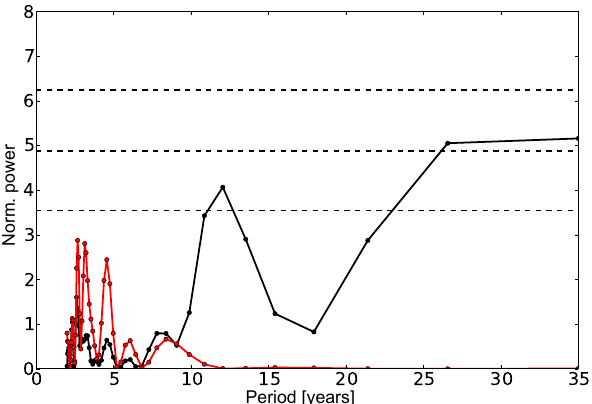
Figure 13. The Lomb–Scargle periodogram for the time series of annual OH ∗ temperatures (see Fig. 1 lower panel) is shown in black and the LPS for the residual after subtracting the fit according to Eq. (10) (see Fig. 12 lower panel) is shown in red. For details see description of Fig.